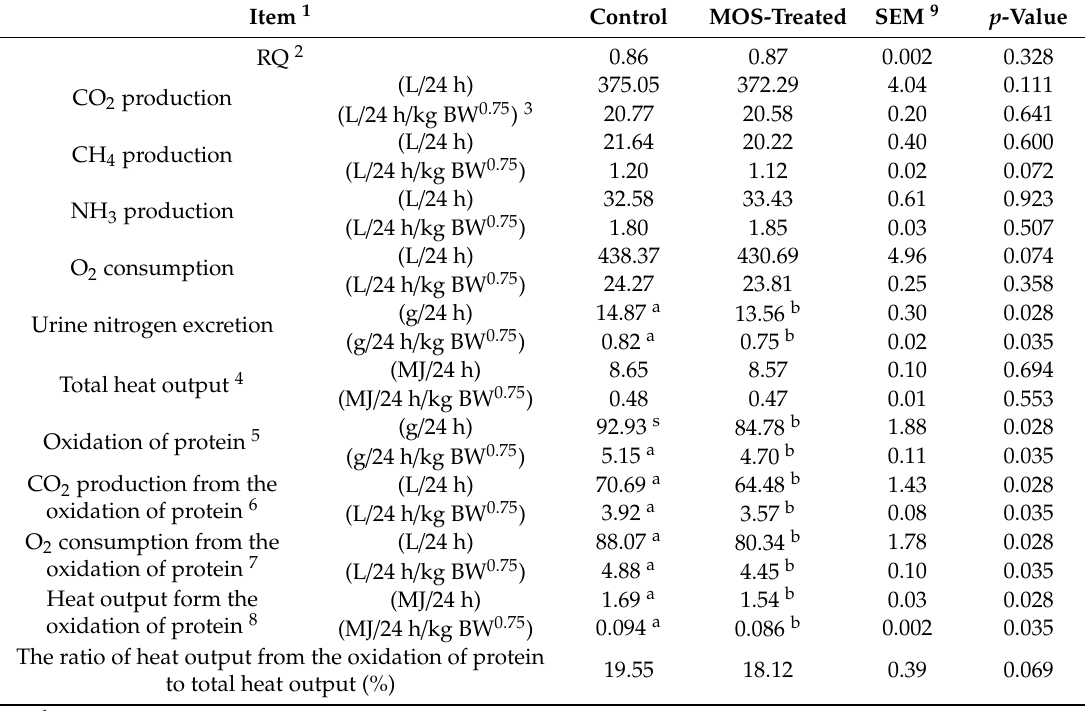
Table 3. In vivo gas production and energy metabolism of control and MOS-treated sheep. Item 1